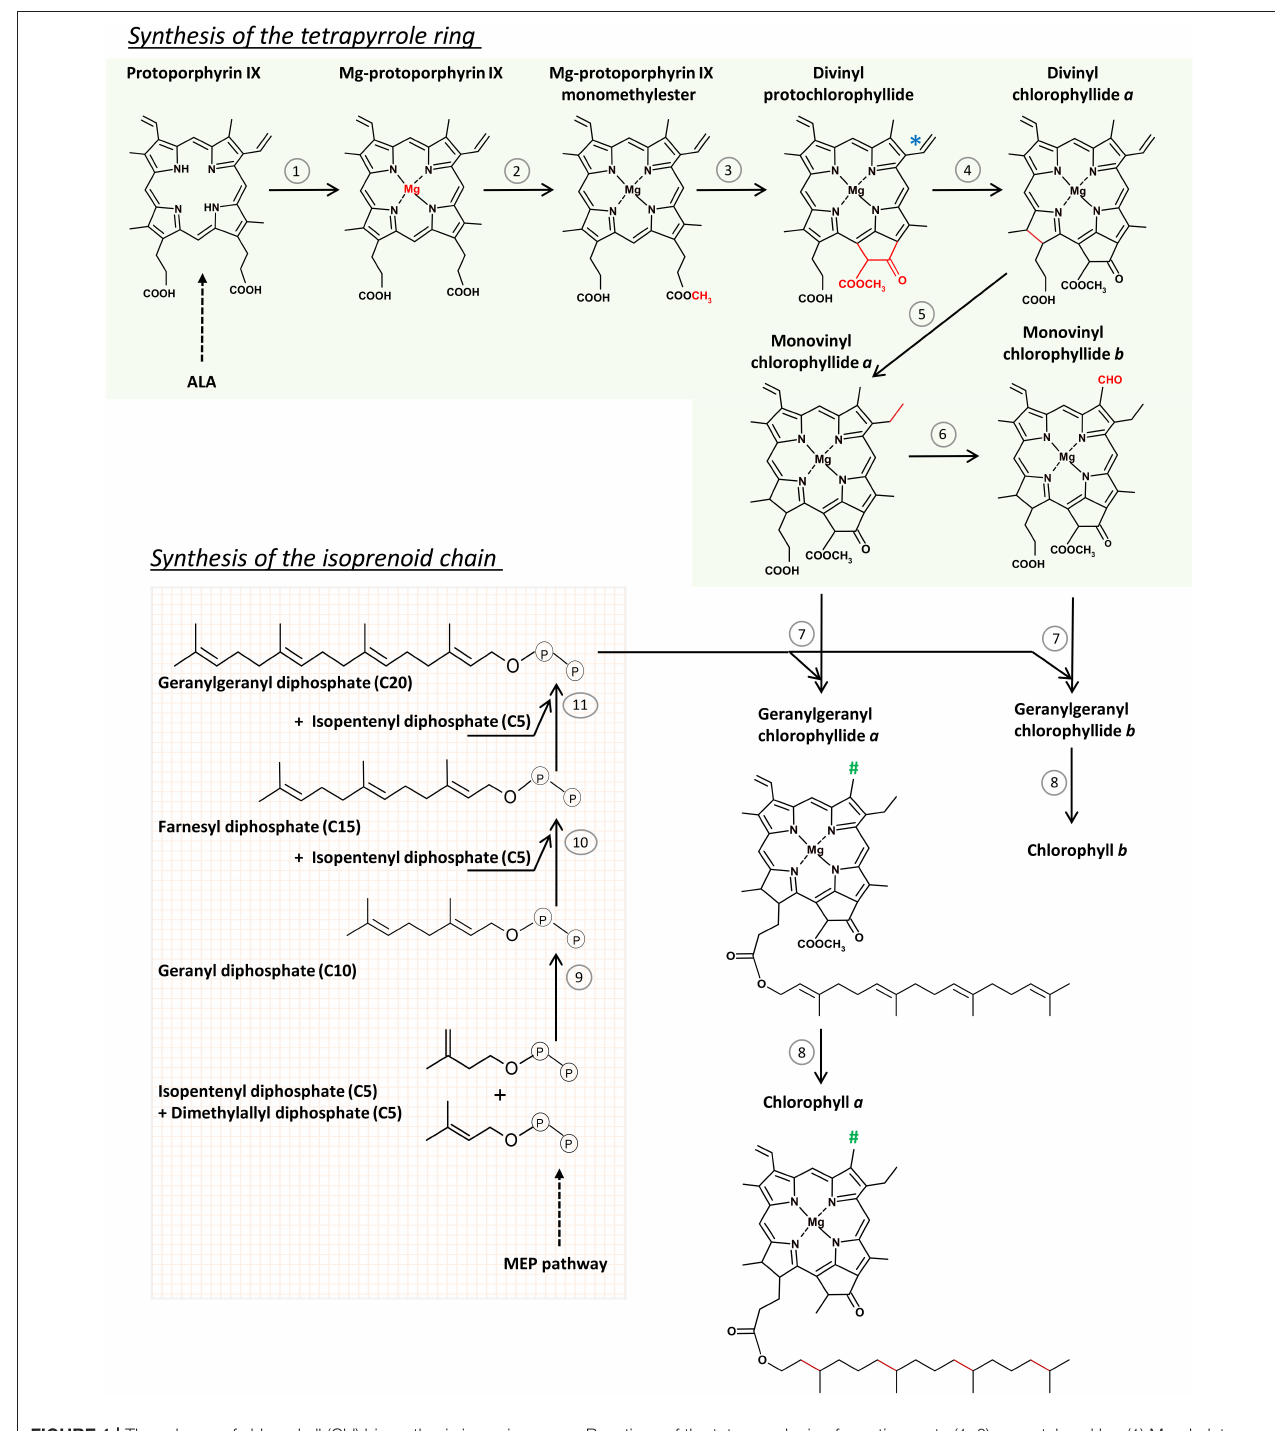
FIGURE 1 | The scheme of chlorophyll (Chl) biosynthesis in angiosperms. Reactions of the tetrapyrrole ring formation route (1–6) are catalyzed by: (1) Mg-chelatase, (2) protoporphyrin IX methyltransferase, (3) Mg protoporphyrin IX monomethyl ester (oxidative) cyclase, (4) light-dependent NADPH:protochlorophyllide oxidoreductase, (5) divinyl reductase, (6) chlorophyllide oxygenase, (7) chlorophyll synthase, (8) geranylgeranyl reductase. (*) Divinyl reductase (5) can also convert the indicated divinyl group to a monovinyl group in protochlorophyllide molecule. (#) Methyl group in Chl a , and formyl group in Chl b . Reactions of the isoprenoid chain formation (9–11) are catalyzed by geranyl diphosphate and geranylgeranyl diphosphate synthases. See text for further explanations.